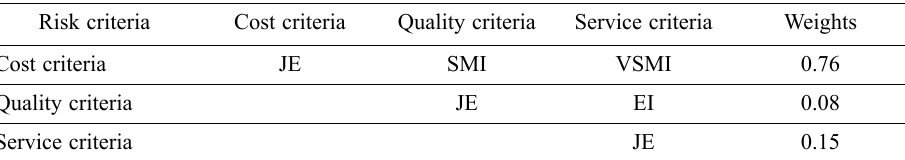
Table 11. Inner-dependency matrix of the criteria with respect to